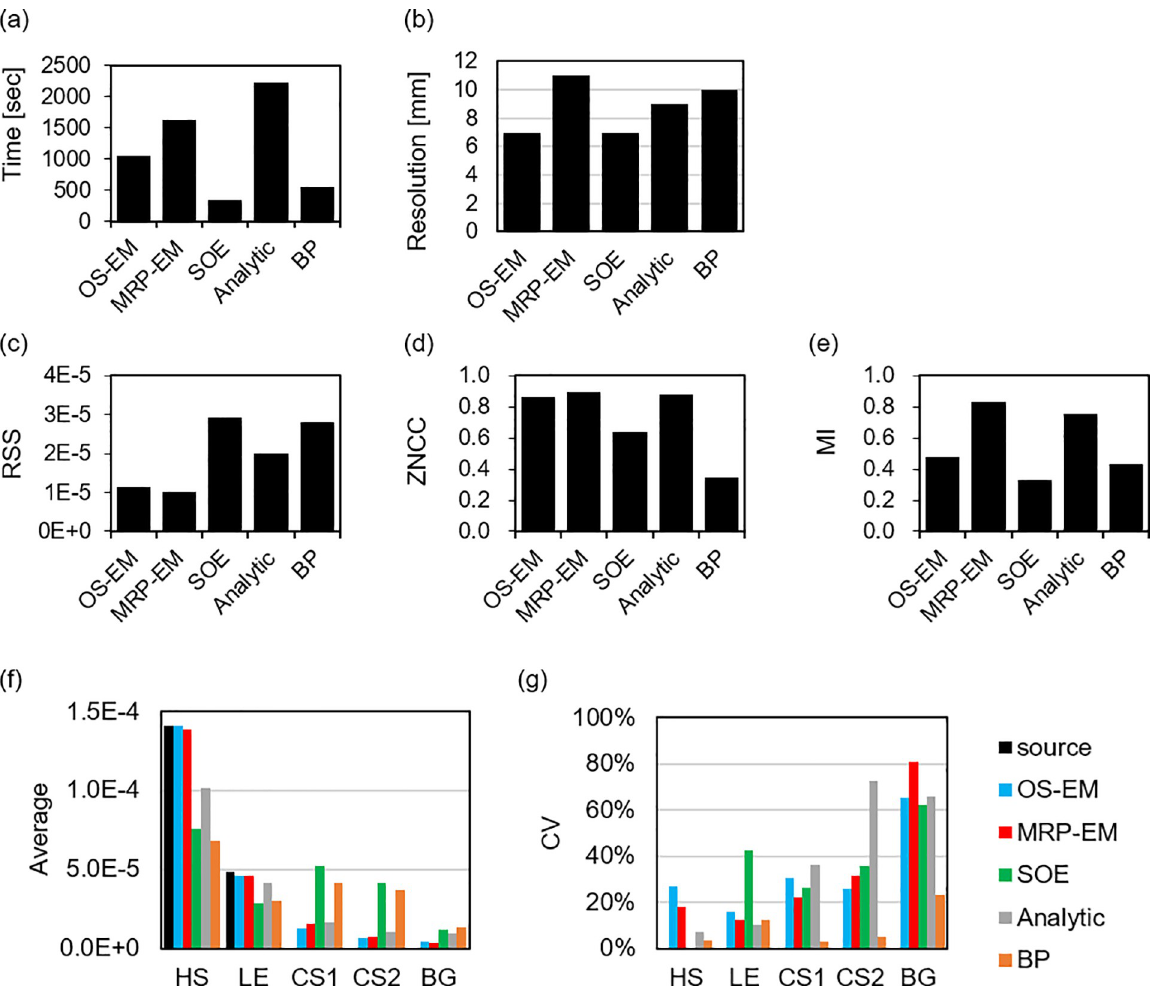
Fig 7. Comparison of image quality of BP, Analytic algorithm, OS-EM with 10 iterations, MRP-EM with 20 iterations, and SOE with 200 iterations. (a) Reconstruction time (shorter is better), (b) spatial resolution (shorter is better), (c) RSS (smaller is better), (d) ZNCC (higher is better), (e) MI (higher is better), (f) average values in each position, and (g) CV in each position.